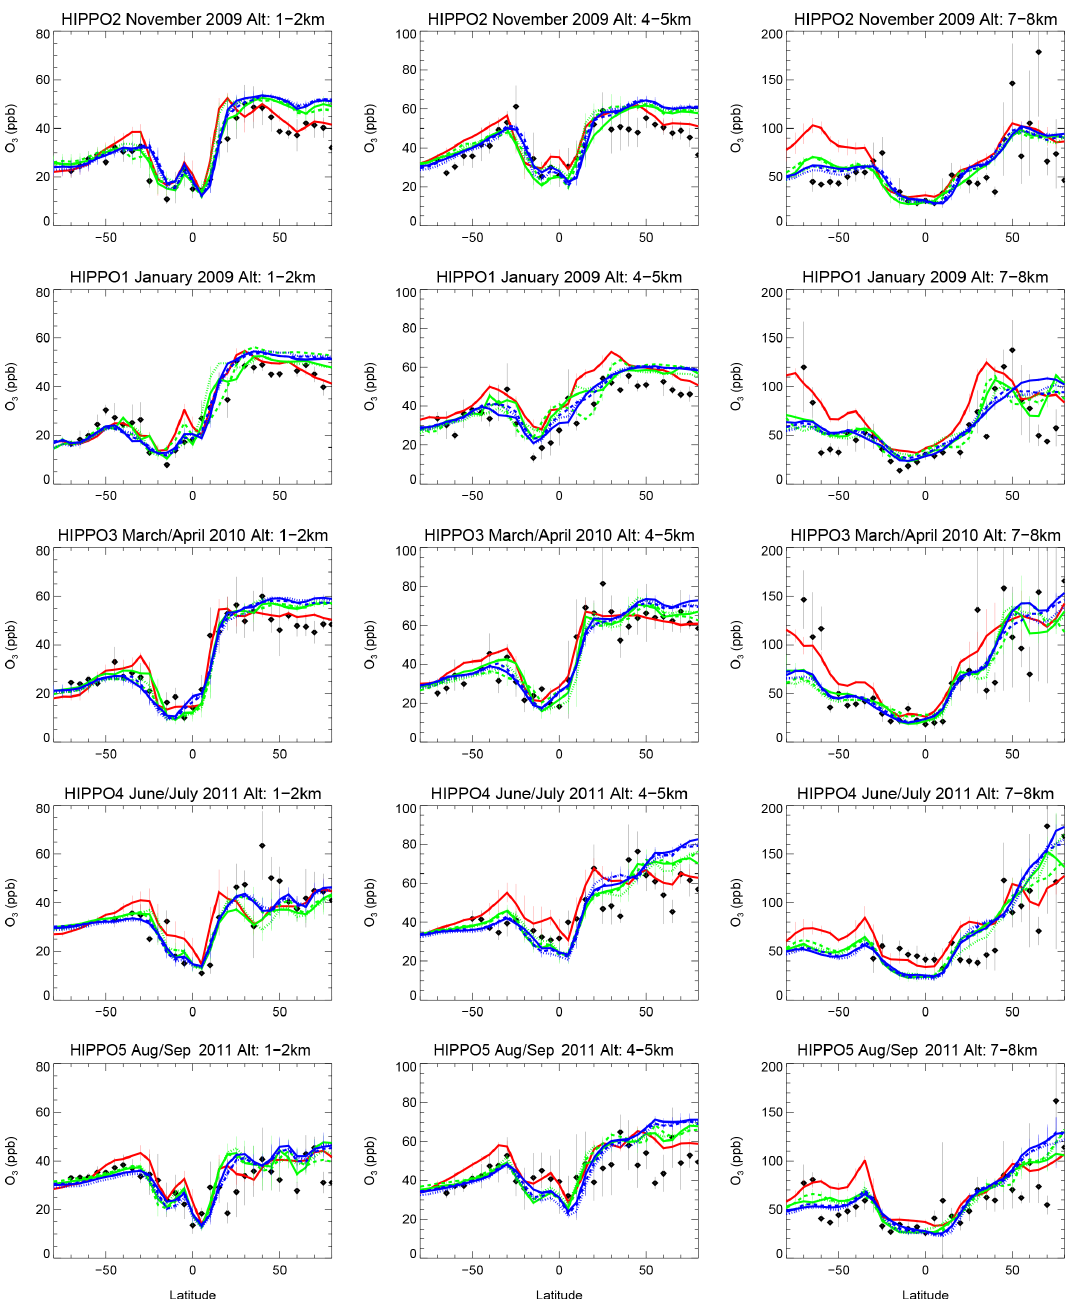
Figure A2. O 3 comparison between different HIPPO aircraft campaigns taken over the Pacific Ocean (black symbols) and results from the reference simulations REFC1SD (red), REFC1 (green), REFC2 (blue), averaged over different altitude intervals. The sampled aircraft profiles during different HIPPO campaigns were averaged over 5 ◦ latitude intervals along the flight path over the Pacific Ocean and compared to model output averaged over the same grid points, as done in Tilmes et al. (2015). The average profiles are averaged over three altitudes regions, 1–2, 4–5 and